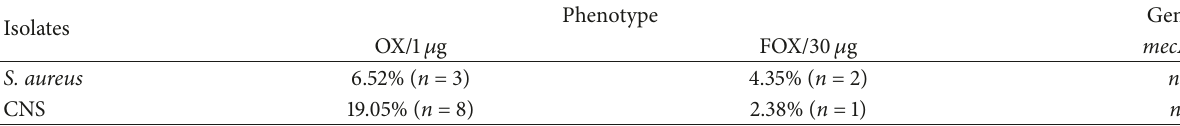
Table 3: Phenotypic and genotypic identification of methicillin-resistant isolates.